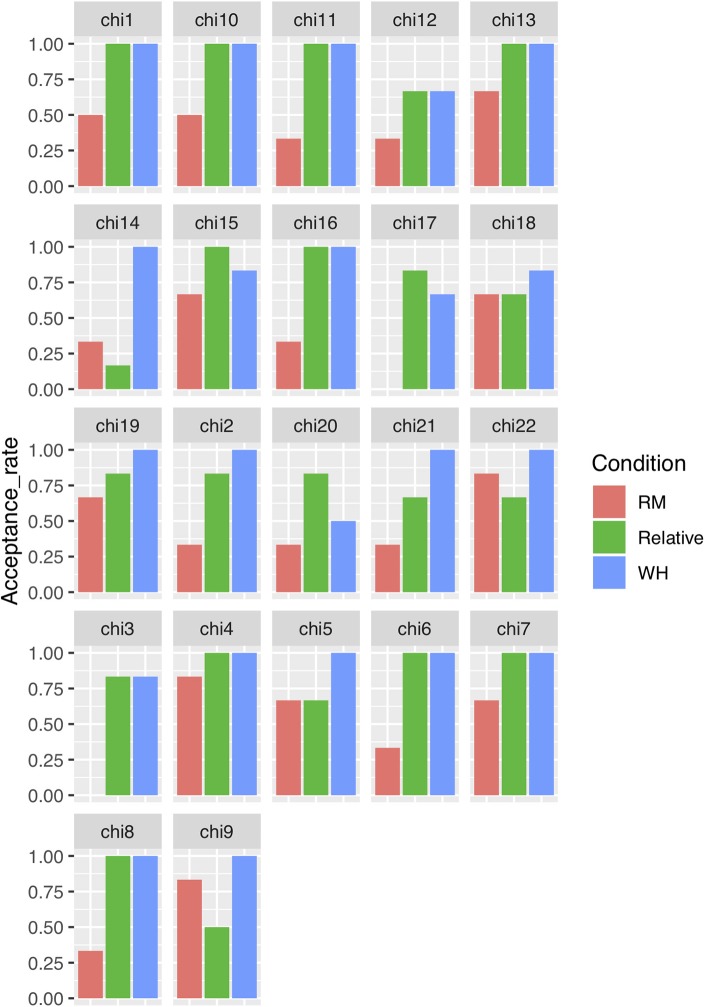
Individual results.